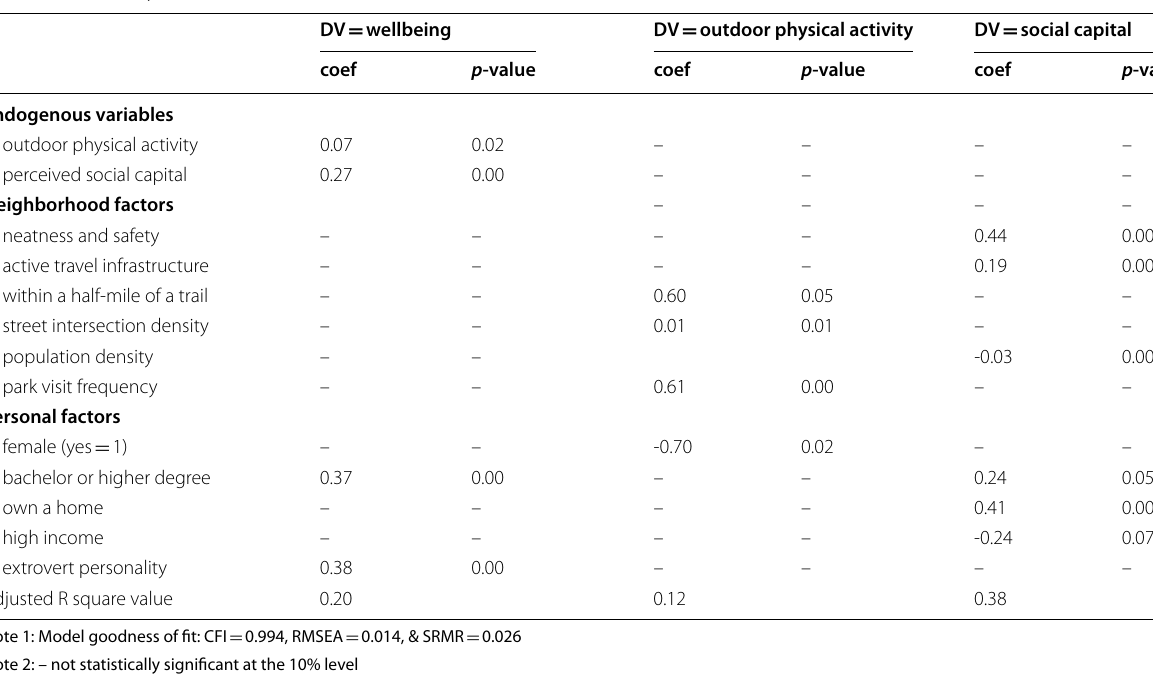
Table 3 Path analysis model results